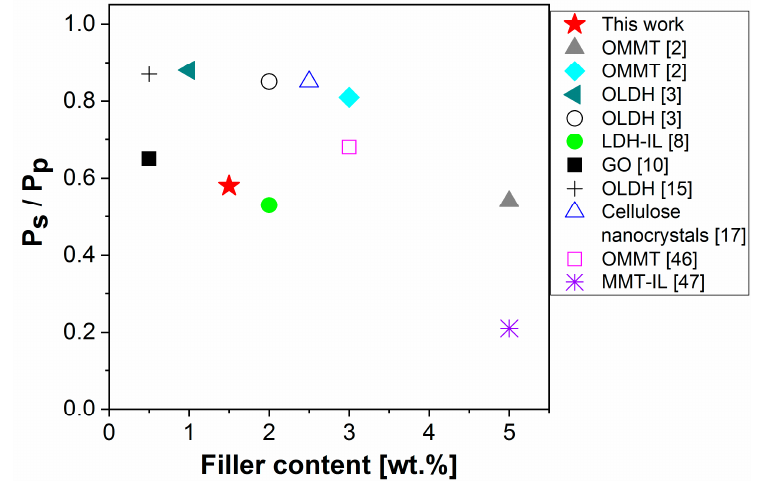
Figure 6. Comparison of relative permeability values (P s / P p ) between this work (PBAT nanocomposite with 1.5 wt % of LDH-phosphate) and other PBAT / filler